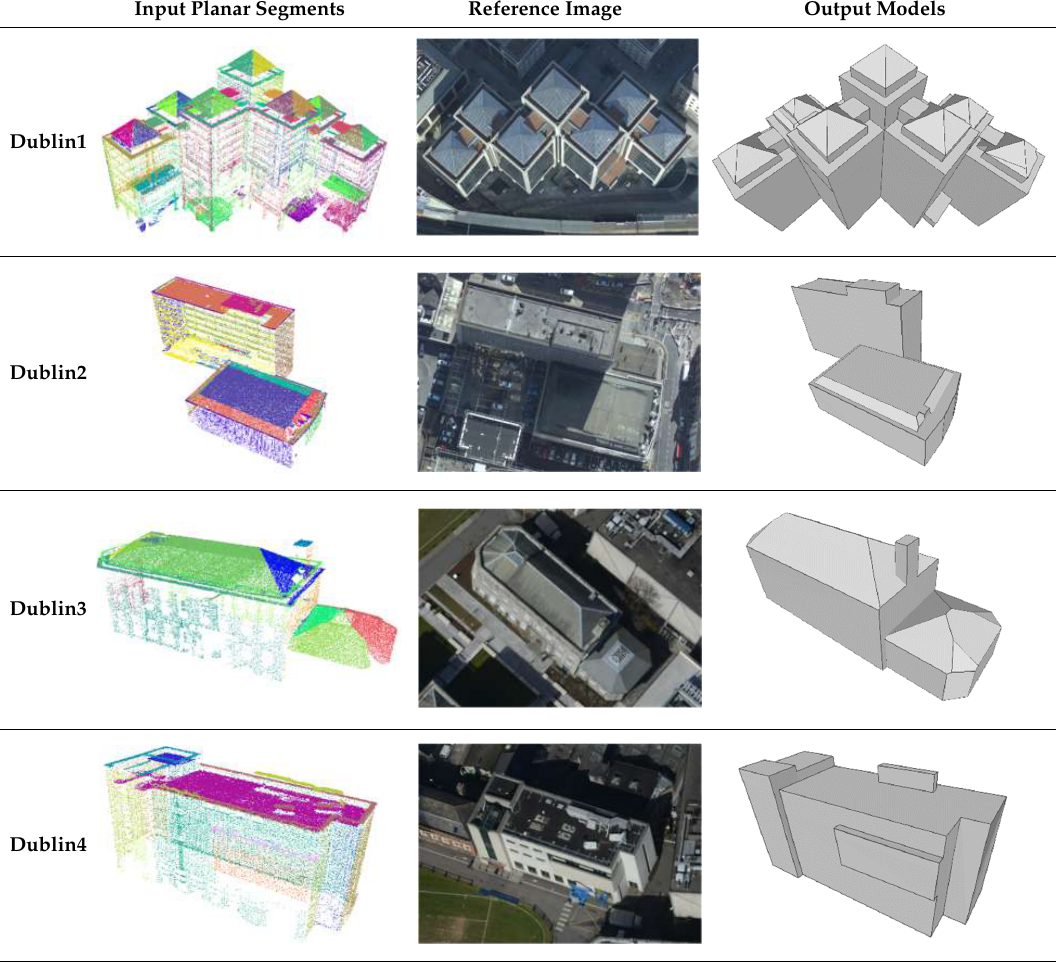
Table 1. Data overview and modeling results.